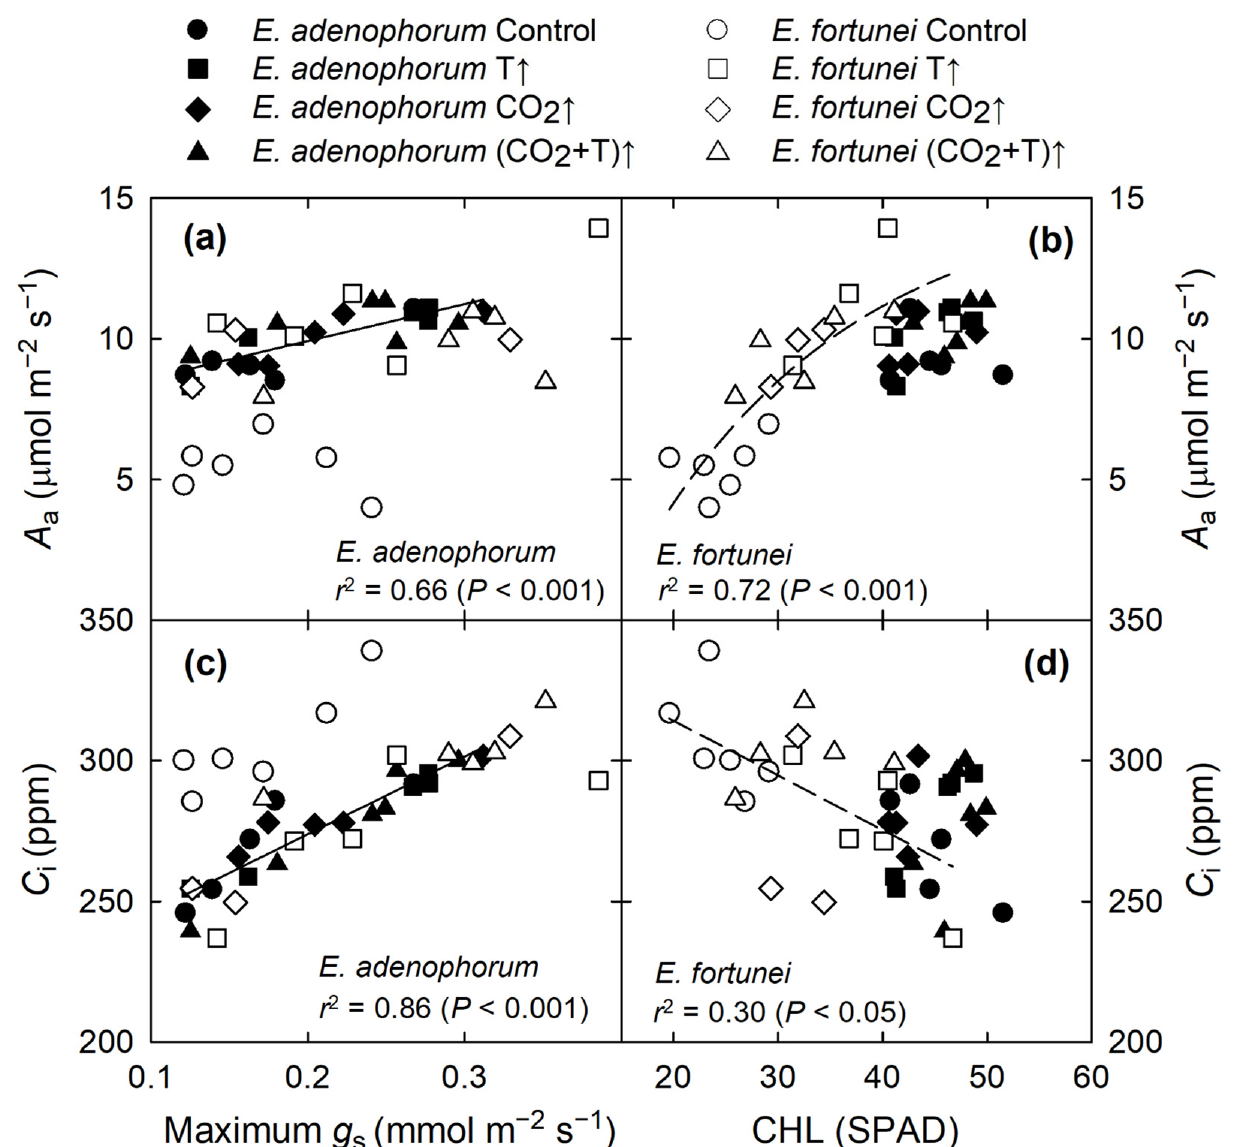
Figure 4. The relationship between stomatal conductance ( g s ) and light-saturated photosynthetic rate per leaf area ( A a ; a ), between Chlorophyll concentration (CHL) and A a ( b ), between g s and intercellular CO 2 concentration C i ( c ), and between CHL and C i ( d ). Each point represents a value of a leaf from a specific individual (one leaf per individual). Solid lines are regressions fitted to Eupatorium adenophorum , while dash lines are regressions fitted to E. fortunei . The relationship between Chlorophyll concentration and A a in E. fortunei was described by an exponential function, while other relationships were fitted with linear regressions.